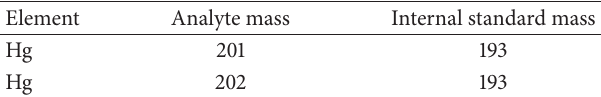
Table 2: Isotopes of Hg for ICP-MS, used with an iridium internal standard.